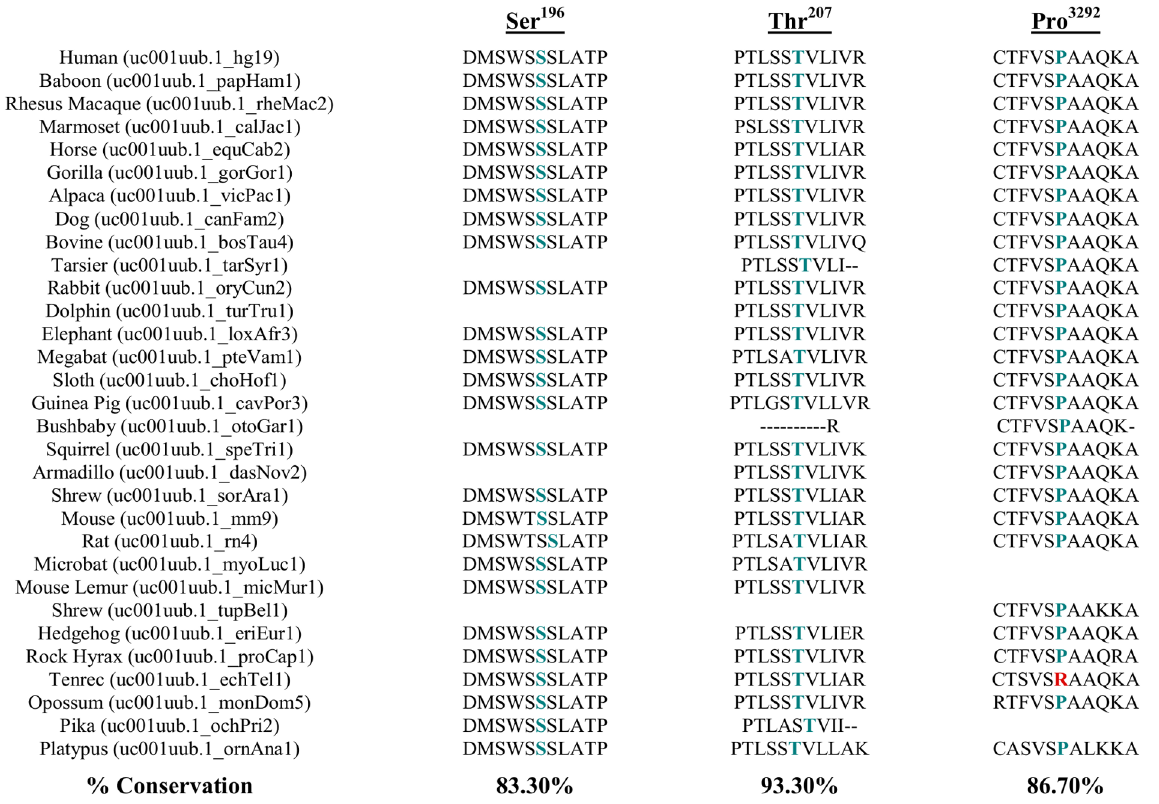
Figure 3. Multiple sequence alignment demonstrating phylogenetic conservation of the three biologically characterized phosphorylated BRCA2 residues affected by missense variants of unknown clinical significance.